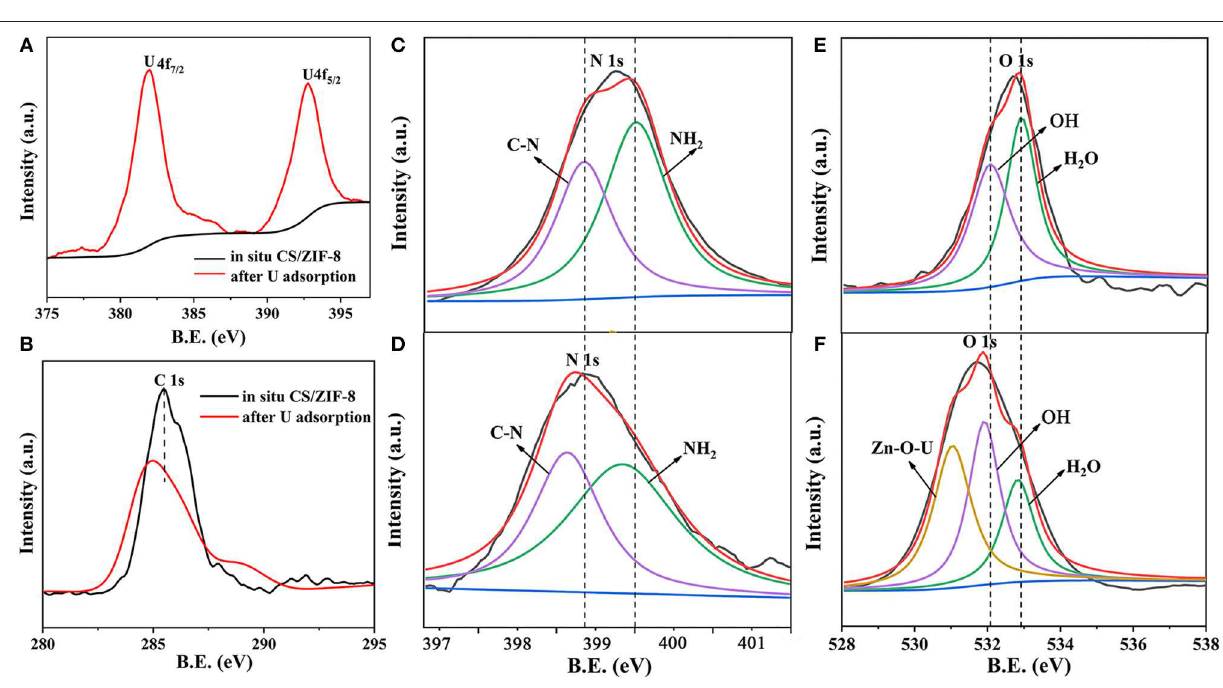
FIGURE 9 | XPS survey scans of CS/ZIF-8–60% before and after U(VI) uptake; high-resolution XPS spectra of U 4f (A) , C 1s (B) , N 1s (C,D) , O 1s (E,F) before and after U(VI)